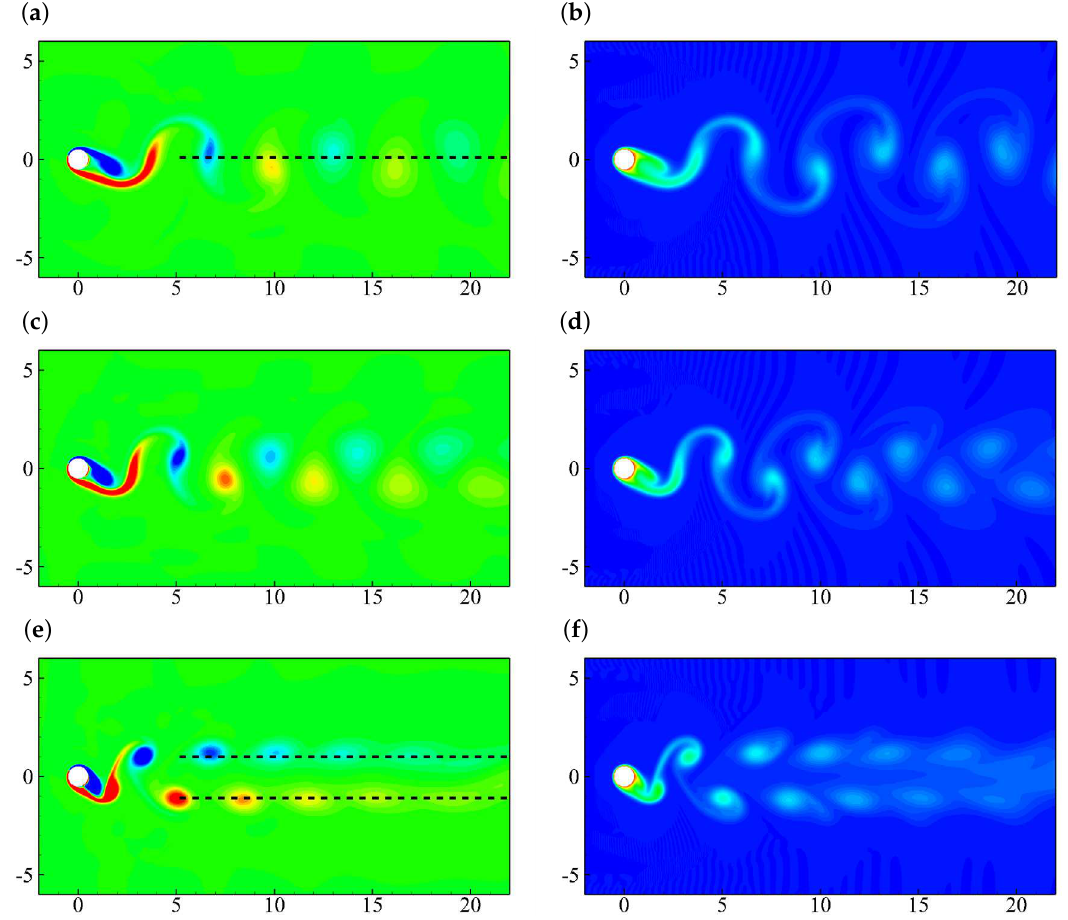
Figure 11. Instantaneous vorticity (left column, ranging from − 2 U 0 / D to 2 U 0 / D ) and temperature (right column, ranging from 0 to 1.0) contours at Re = 100, Pr = 1.0, H 0 = 1.0, n = 0.6, and f ∗ = 0.8 ( top row), 1.0 ( middle row), and 1.2 ( bottom